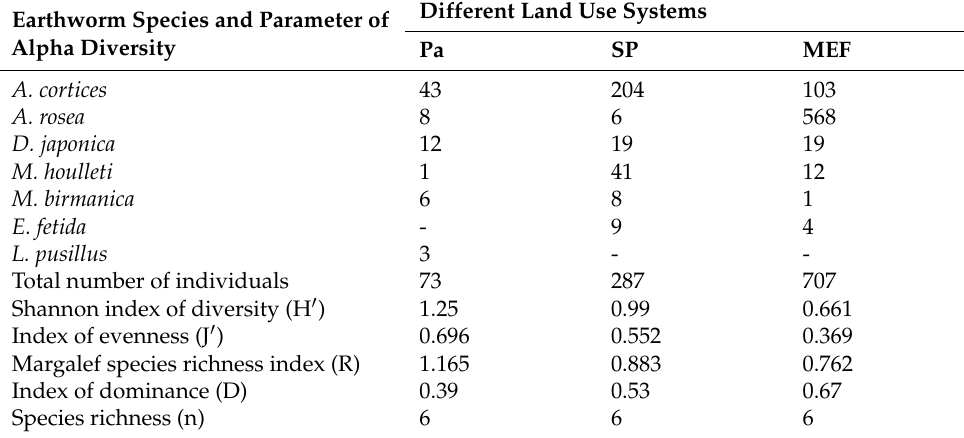
Table 10. Diversity index of earthworms in the three land use